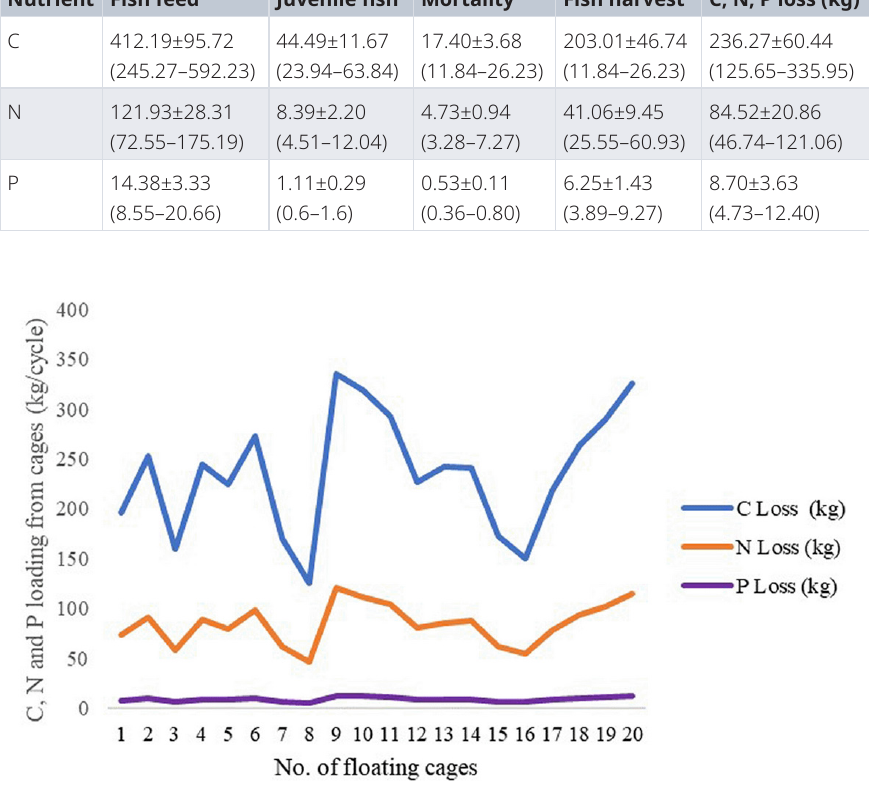
Figure 1. C, N and P loadings of giant gourami reared in floating cages.